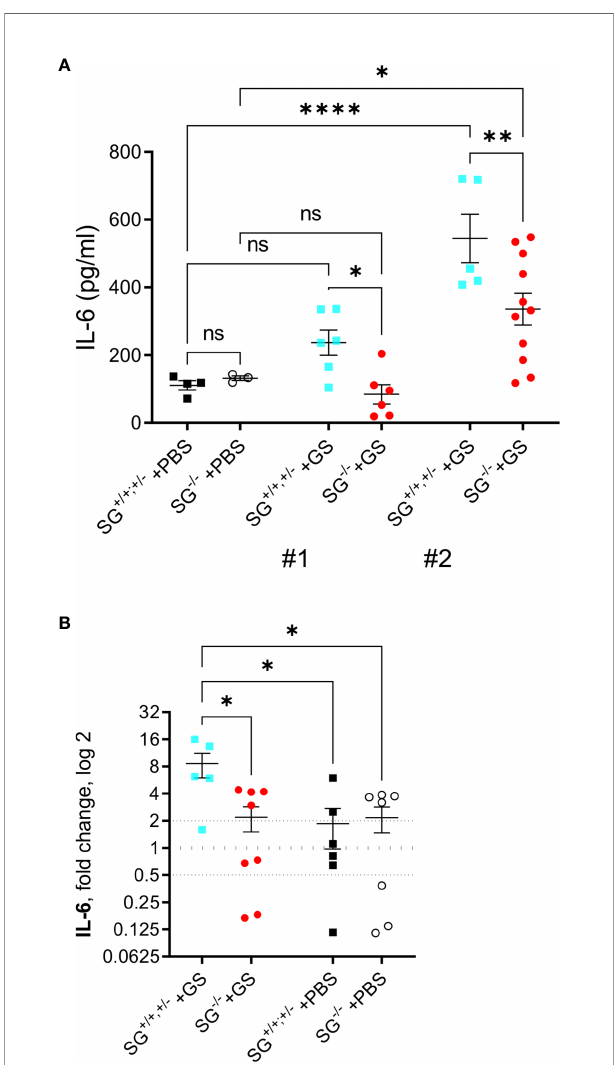
FIGURE 3 | Serum levels of IL-6 and intestinal expression levels of the proin fl ammatory cytokine IL-6 in SG +/+ and SG -/- littermate mice infected with Giardia intestinalis . (A) Serum IL-6 levels in from experimental infections #1 and #2. Relative intestinal expression levels determined by qPCR of (B) IL-6. Fold changes were calculated after normalization to GAPDH_ Dotted lines at 0.5, 1, and 2 indicates down-regulation, no fold change, and up-regulation, respectively. ns, non-signi fi cant, P values * <0.05 ** <0.01, and **** <0.0001 between groups of mice are